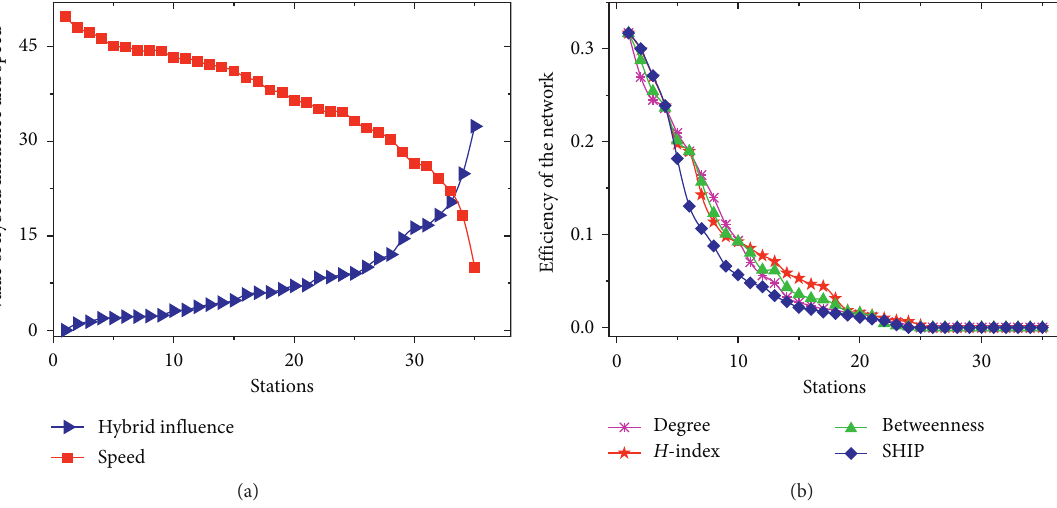
Figure 8: The results of model